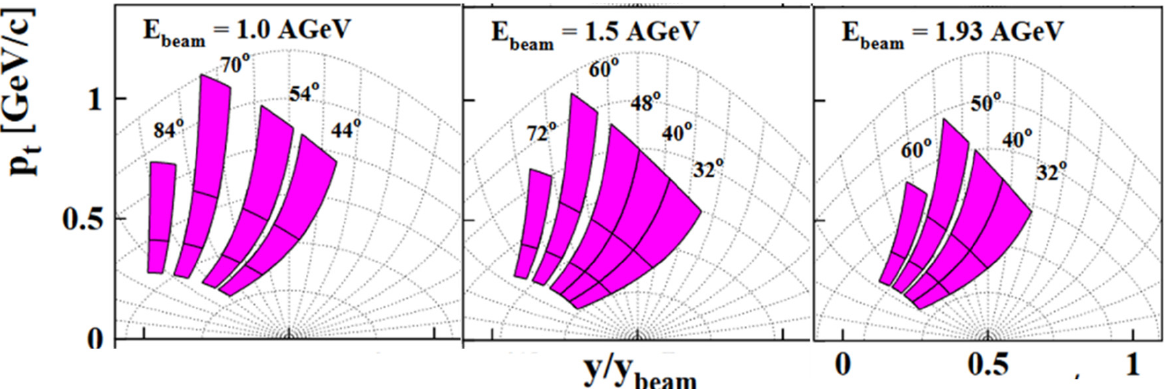
Figure 2. Examples of the acceptance of the kaon spectrometer in the plane transverse momentum versus normalized rapidity y/y beam for several laboratory angles θ lab (as indicated) and for various magnetic field settings at 1.0A GeV, at 1.5A GeV and at 1.93A GeV beam energy. The angular acceptance is ∆θ lab = ±4°, corresponding to the width of the pink bands.